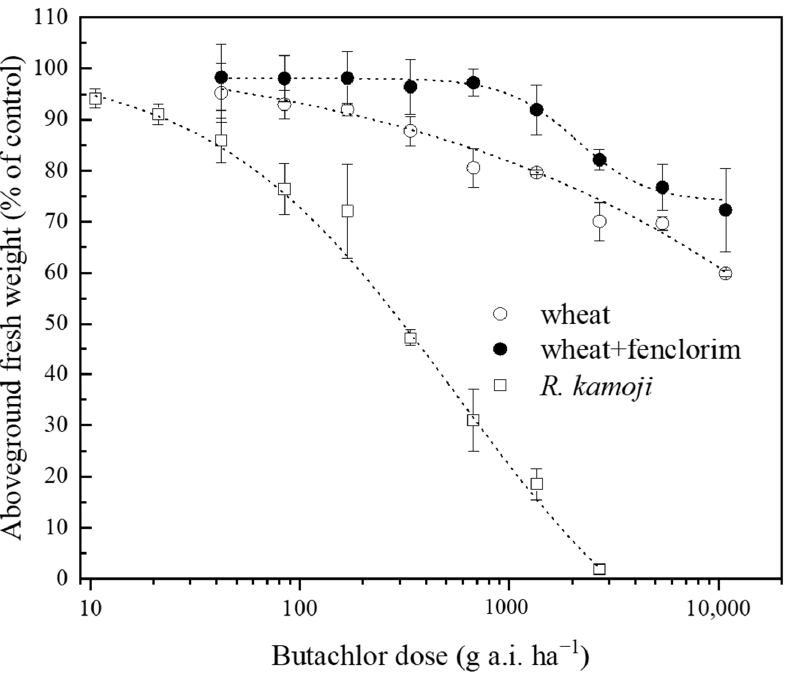
Figure 2. Dose–response curve for the above-ground fresh weight (% of control) of R. kamoji and wheat sprayed with different doses of butachlor with or without fenclorim pre-soaking. Each point represents the mean ± SE of twice-repeated experiments, each including four replications.